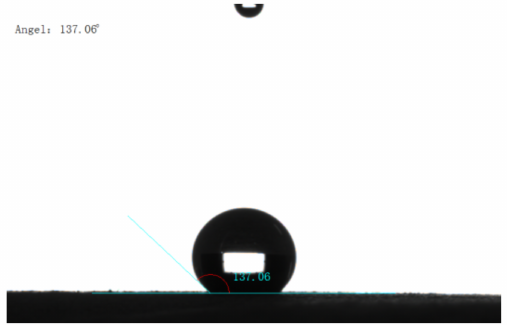
Figure 11. A contact angle image of Sample